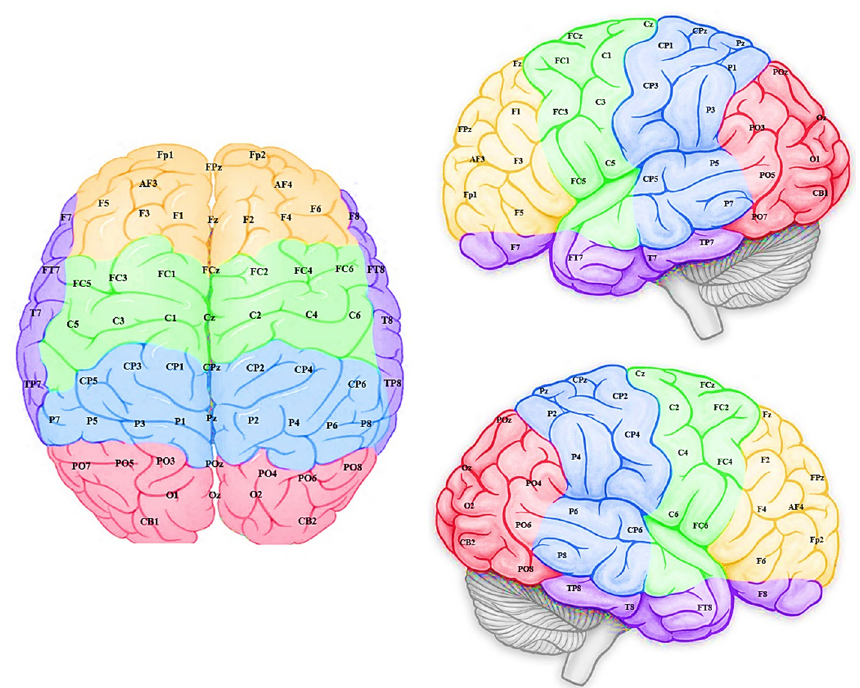
Figure 5. Dividing EEG channels into five sites for both hemisphere (left and right) with respect to their topological information including: yellow colour: left and right frontal (Fp1, AF3, F5,F3, F1 and Fp2, AF4, F6, F4, F2); green colour: left and right frontocentral (FC5, FC3, FC1, C5, C3, C1 and FC6, FC4, FC2, C6, C4, C2); purple colour: left and right temporal (F7, FT7, T7, TP7 and F8, FT8, T8, TP8); blue colour: left and right centroparietal (CP5, CP3, CP1, P7, P5, P3, P1 and CP6, CP4, CP2, P8, P6, P4, P2);pink colour: left and right occipitoparietal (PO7, PO5, PO3,O1, CB1 and PO8, PO6, PO4, O2, CB2).